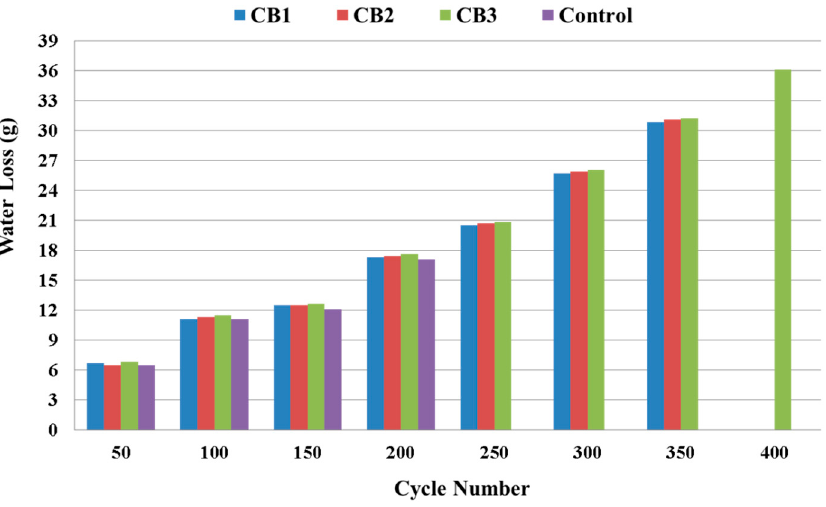
Figure 6. Diagram of the relationship between water loss and the number of cycles.